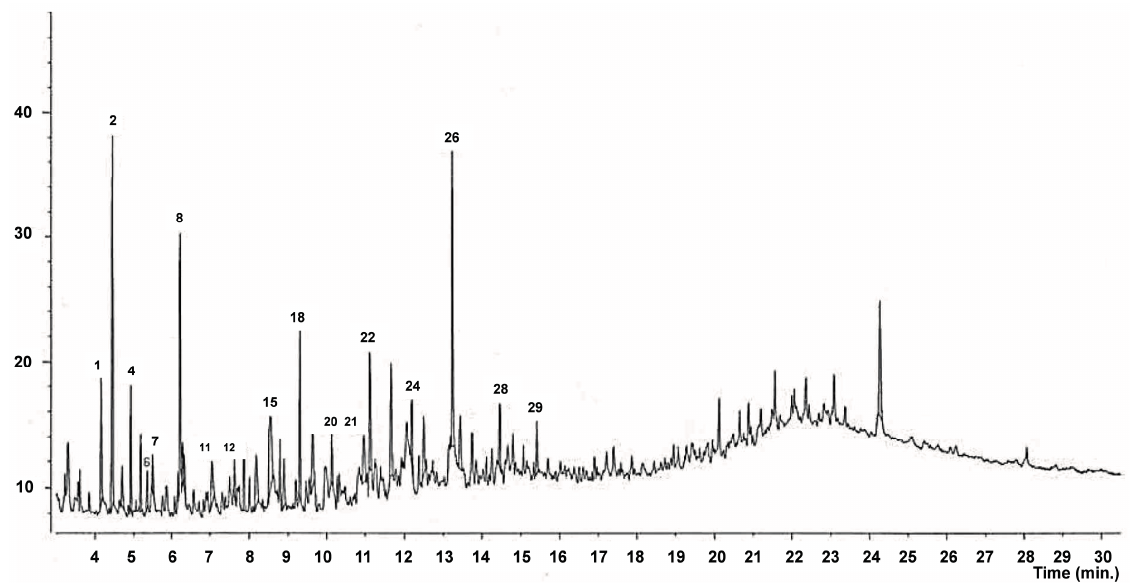
Figure 1. GC-MS spectra of Japanese red pine sawdust bio-oil